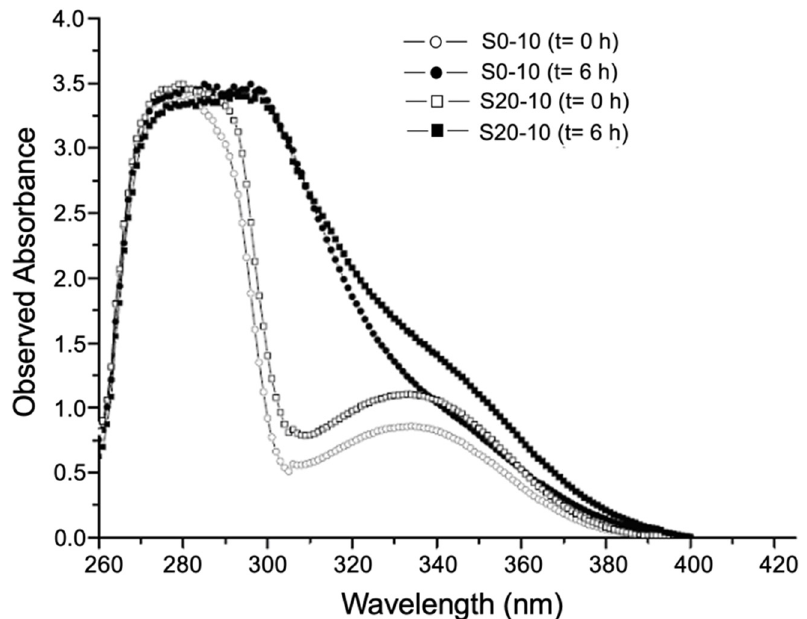
Figure 7. UV-Vis spectra (at the λ max of AN) of the two ionomers before and after 6 h of copolymer- ization: the monomer mixture S0-10 ( ○ ) and its partially polymerized product ( ● ); the monomer mixture S20-10 ( □ ) and its partially polymerized product ( ■ ).